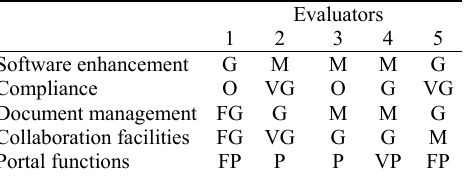
Table 4. The linguistic evaluation of alternative A